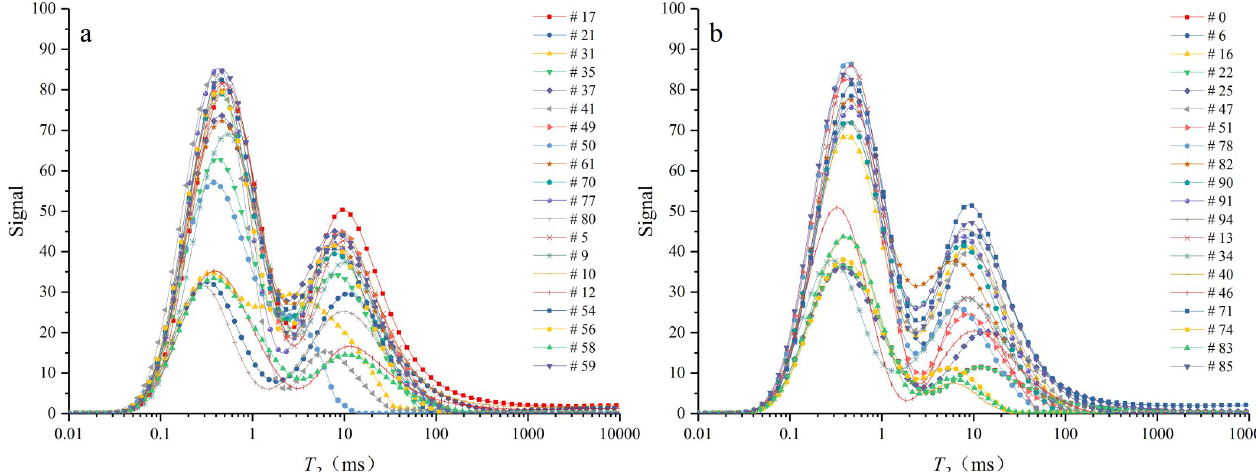
Fig 11. T 2 spectra of coal samples. (a) dry samples, (b) water-saturated samples.